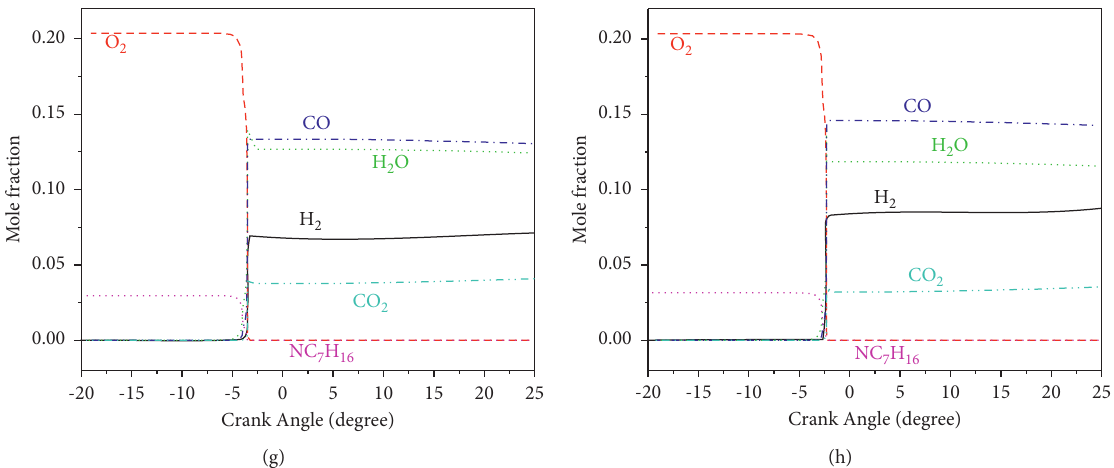
Figure 3: Variations in the mole fraction of the reforming species at different n-heptane equivalence ratios. (a) Φ Φ FR � 1 . 2. (d) Φ FR � 1 . 3. (e) Φ FR � 1 . 4. (f) Φ FR � 1 . 5. (g) Φ FR � 1 . 6. (h) Φ FR � 1 . 7.